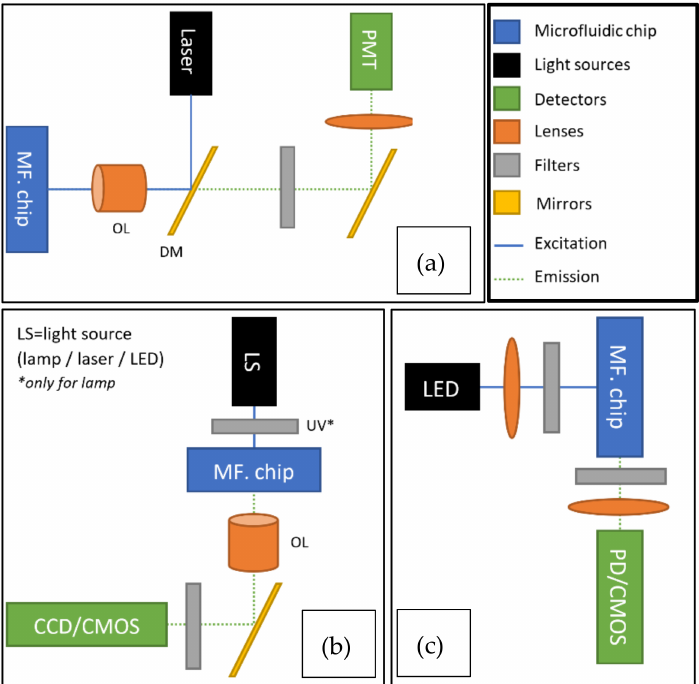
Figure 2. Typical light path configurations applicable in droplet microflow cytometry (DMFC) setups, using lasers, light-emitting diodes (LEDs), and arc discharge lamps as light sources. Setups are fine-tuned by the addition of filters and lenses of various types to focus and filter excitation and emission beams. ( a ) Typical fluorescent event counting setup with a laser as the light source and objective lens (OL) and two dichroic mirrors (DM) to focus and direct fluorescent emission [14,43–46]. ( b ) Typical fluorescent microscopy setup using a mercury arc or halogen lamp and a set of filters to select the appropriate excitation wavelength [61,69]. Alternatively, laser/LED excitation can be used without excitation filtering [70,71]. ( c ) Compact LED-based fluorescent imaging/microscopy setup [25,72]. Only narrow-band LEDs are suitable for use without excitation filtering. By